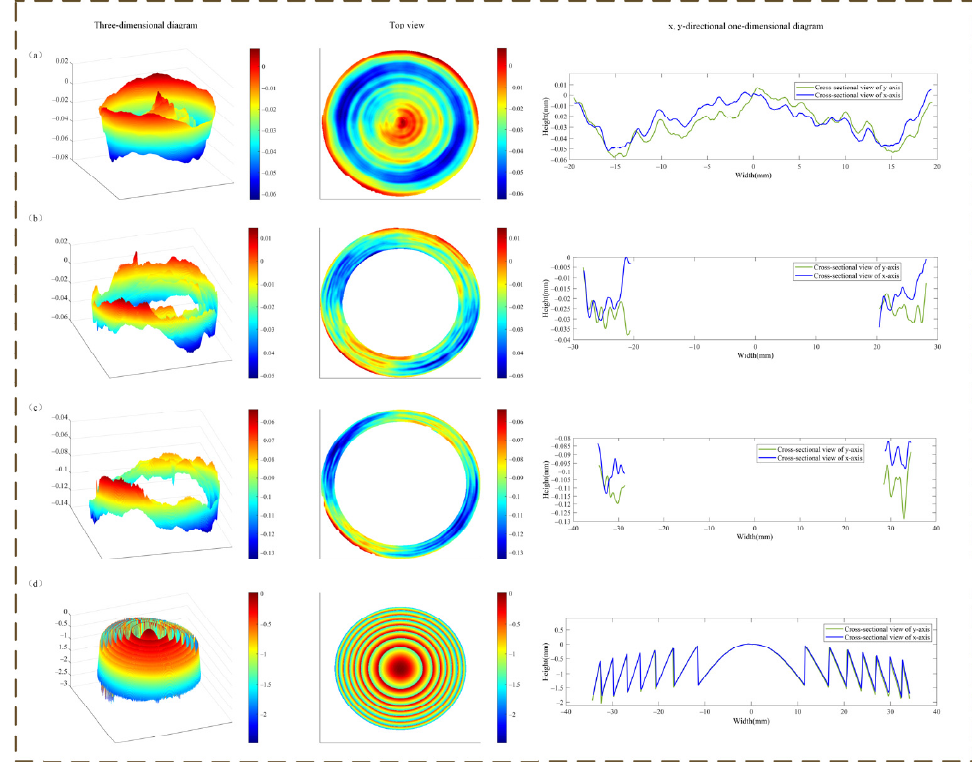
Figure 6. Test results of HMID lens. ( a ) Test results for the first zone of HODS; ( b ) Test results for the second zone of HODS; ( c ) Test results for the third zone of HODS; ( d ) Test results for the FODS.